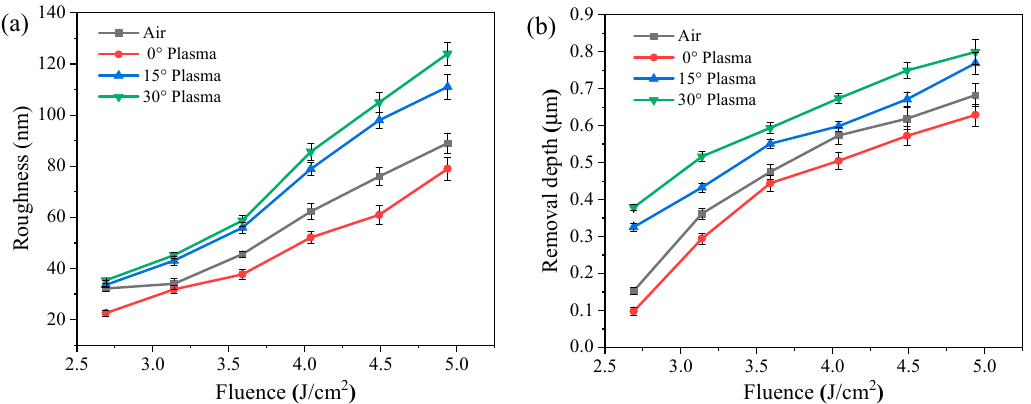
Figure 7. Correlation between laser fluence and processing quality of Cu films ablated by nitrogen plasma − assisted ps − lasers: ( a ) roughness and ( b ) removal depth.